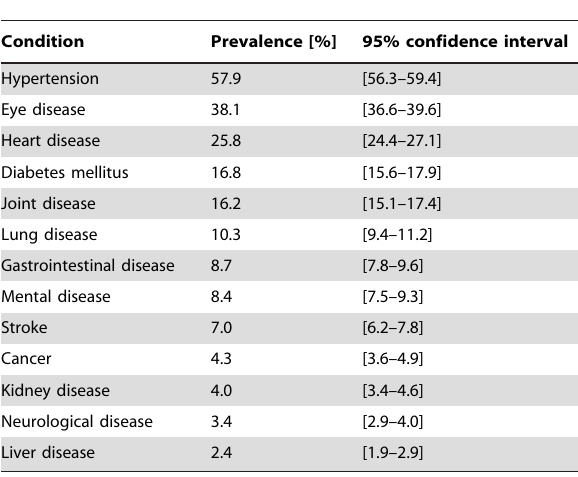
Table 2. Prevalences of the 13 chronic